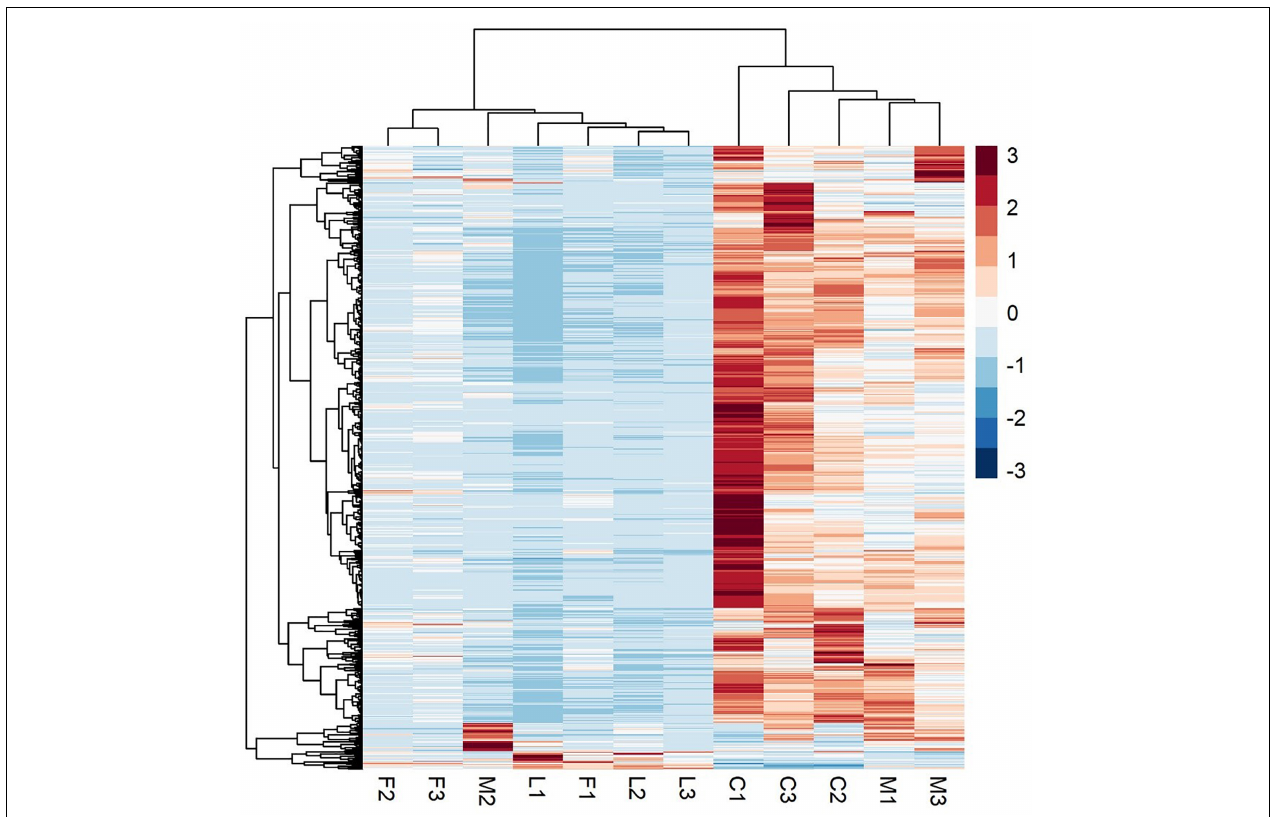
FIGURE 7 | A heatmap of RNA-Seq expression z-scores computed for genes that are significantly differentially expressed Benjamini-Hochberg adjusted p -Value ( p < 0.05) in any comparison. The genes (rows) and samples (columns) are clustered using the Pearson Correlation distance and complete linkage hierarchical clustering. The color code shows the row z-score, with a red color indicating higher expression of a gene and blue color indicating lower expression of a gene. This heatmap demonstrates that C (control) and M (control with axenic MR-VP media) groups, and L (LAC2/MR-VP volatile blend) and F (FZB24/MR-VP volatile blend) groups cluster together and that the genes involved have higher expression in the C and M groups compared with the L and F